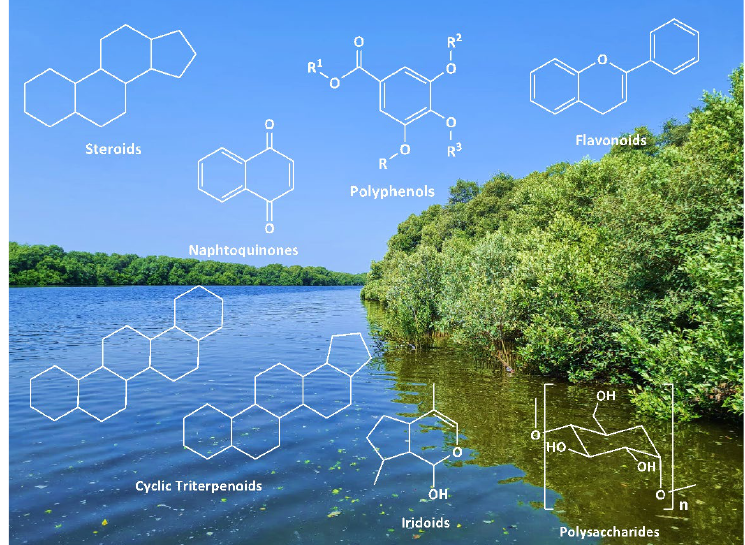
Figure 1. Main classes of compounds extractable from Avicennia marina : cyclic triterpenoids, flavonoids, iridoids, naphtaquinones, polyphenols, polysaccharides, and steroids. The picture was taken in the Al Zorah mangrove lagoon (Ajman,